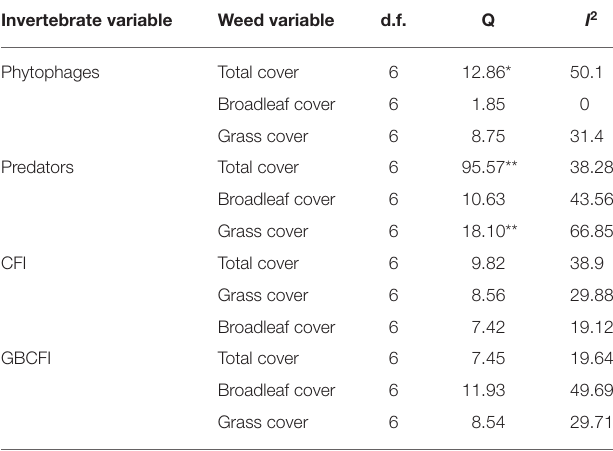
TABLE 8 | Values for d.f., Q and if significant, and I 2 between all seven studies included in analyses. Invertebrate variable